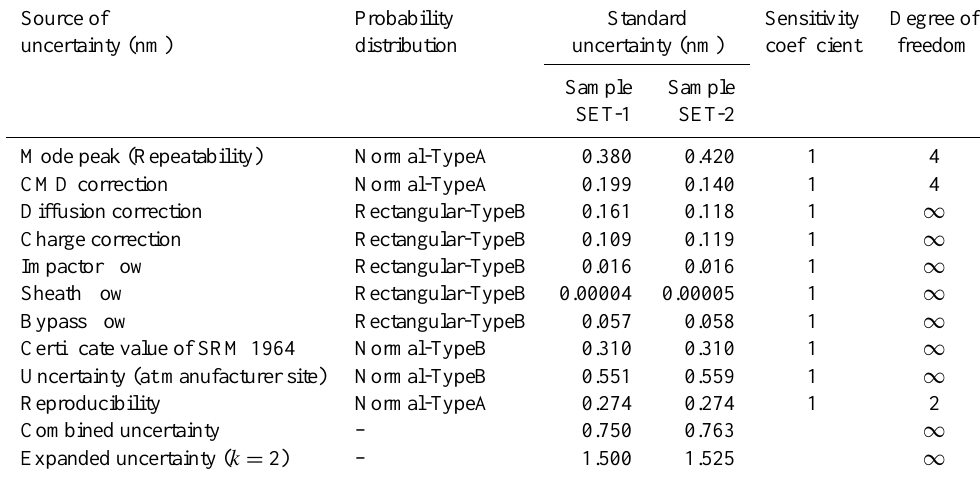
Reproducibility Combined uncertainty Expanded uncertainty ( k = 2)